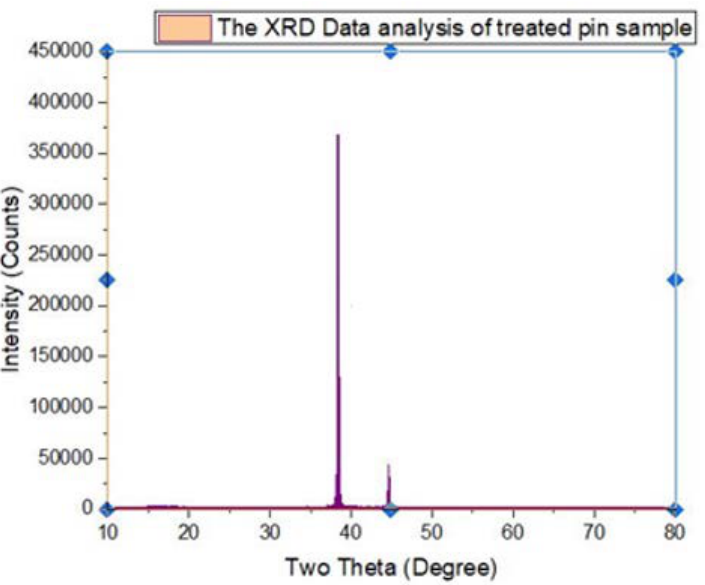
Figure 3. XRD Image of treated pin A7 sample.